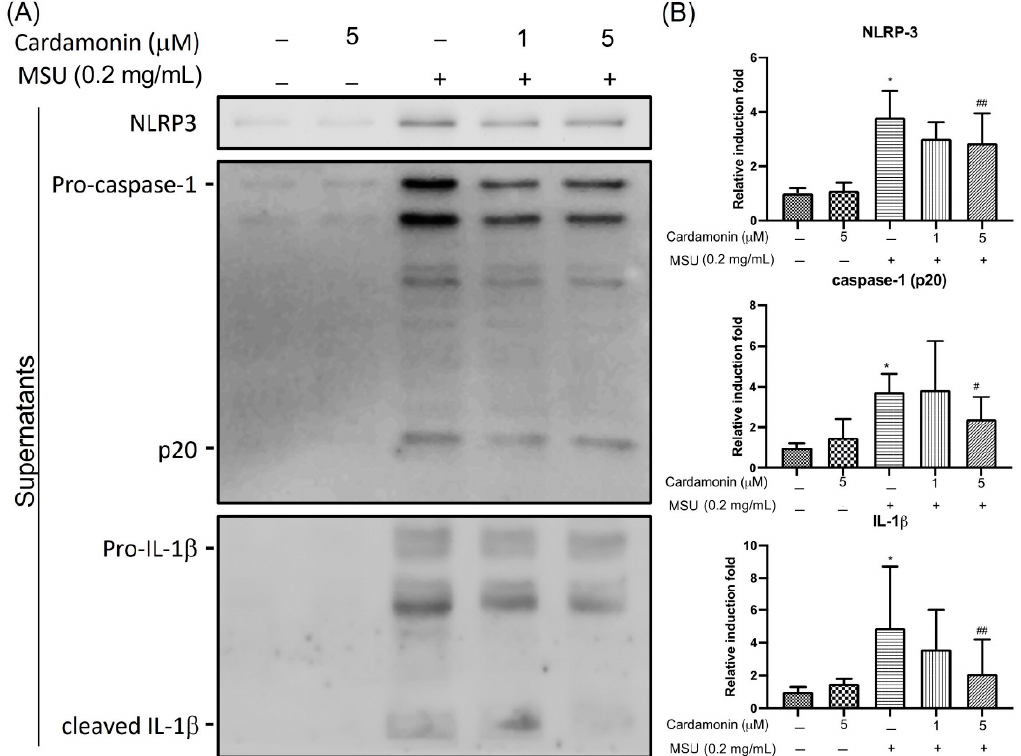
Figure 2. Effects of cardamonin on MSU-stimulated NLRP3 inflammasome activation in J774A.1 macrophage cells treated with MSU for 6 h in the presence or absence of cardamonin: ( A ) Representative gel showing the effect of cardamonin on MSU-stimulated cells. ( B ) Western blot analysis used to detect levels of NLRP3, caspase-1, and IL-1 β in supernatants. (–) not treatment; (+) treatment. Each value represents the mean ± SD. Statistical differences among the MSU groups were compared against the control values, whereas cardamonin groups were compared against the MSU group using the ANOVA test ( n = 5; * p < 0.05 vs. control; # p < 0.05 vs. MSU; ## p < 0.01 vs. MSU).